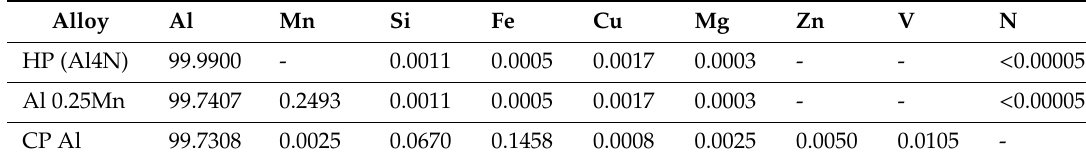
Table 1. Chemical composition of the three alloys used